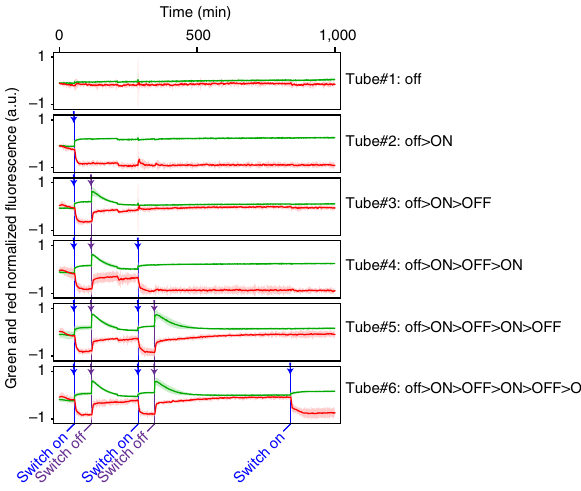
Figure 5 | Reversible ON–OFF switching of a bistable system. A series of replicate tubes containing the bistable system g to g Cy3.5/drain g are prepared in the 0 state and repetitively switched ON—by addition of g —and OFF—by addition of a degradable inhibitor (drain g ’). At each stage, all except one tube are actuated to prove the stability of the current state. The behaviour is monitored using both EvaGreen (total concentration of double-stranded DNA) and the red reporter Cy3.5 attached to the template, which shows a negative intensity shift when the template is in double- strand form 25 . Each trace is the mean ± 2 s.d. over three